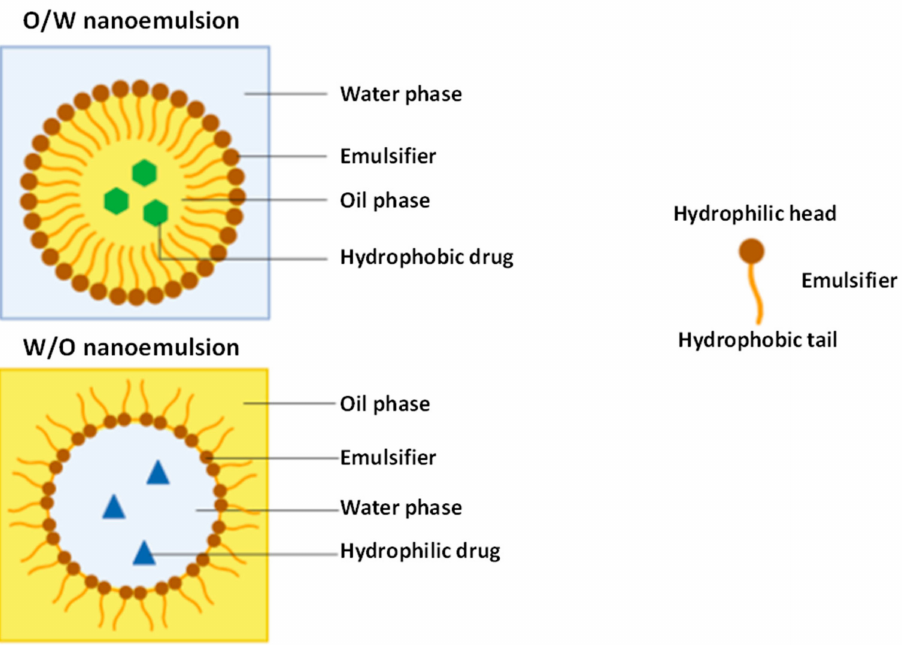
Figure 3. Structure of an O/W nanoemulsion (top) and W/O nanoemulsion (bottom). Adapted from